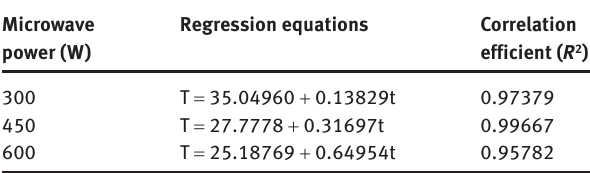
Table 4: Regression equations on sample temperature and